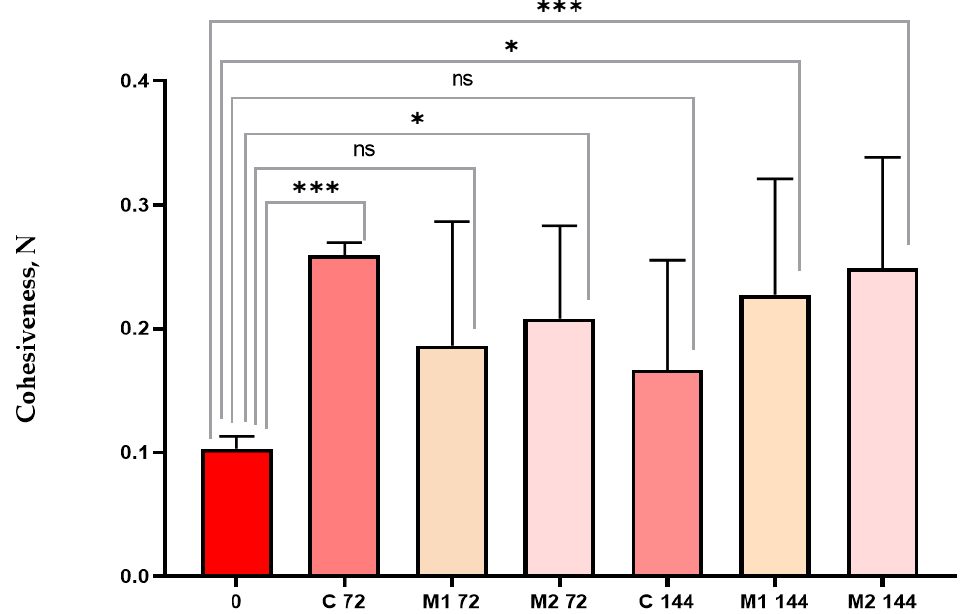
Figure 8. The cohesiveness of the sliced chicken sausage. ANOVA: ns—not significant; ***— p < 0.001; *— p < 0.05.